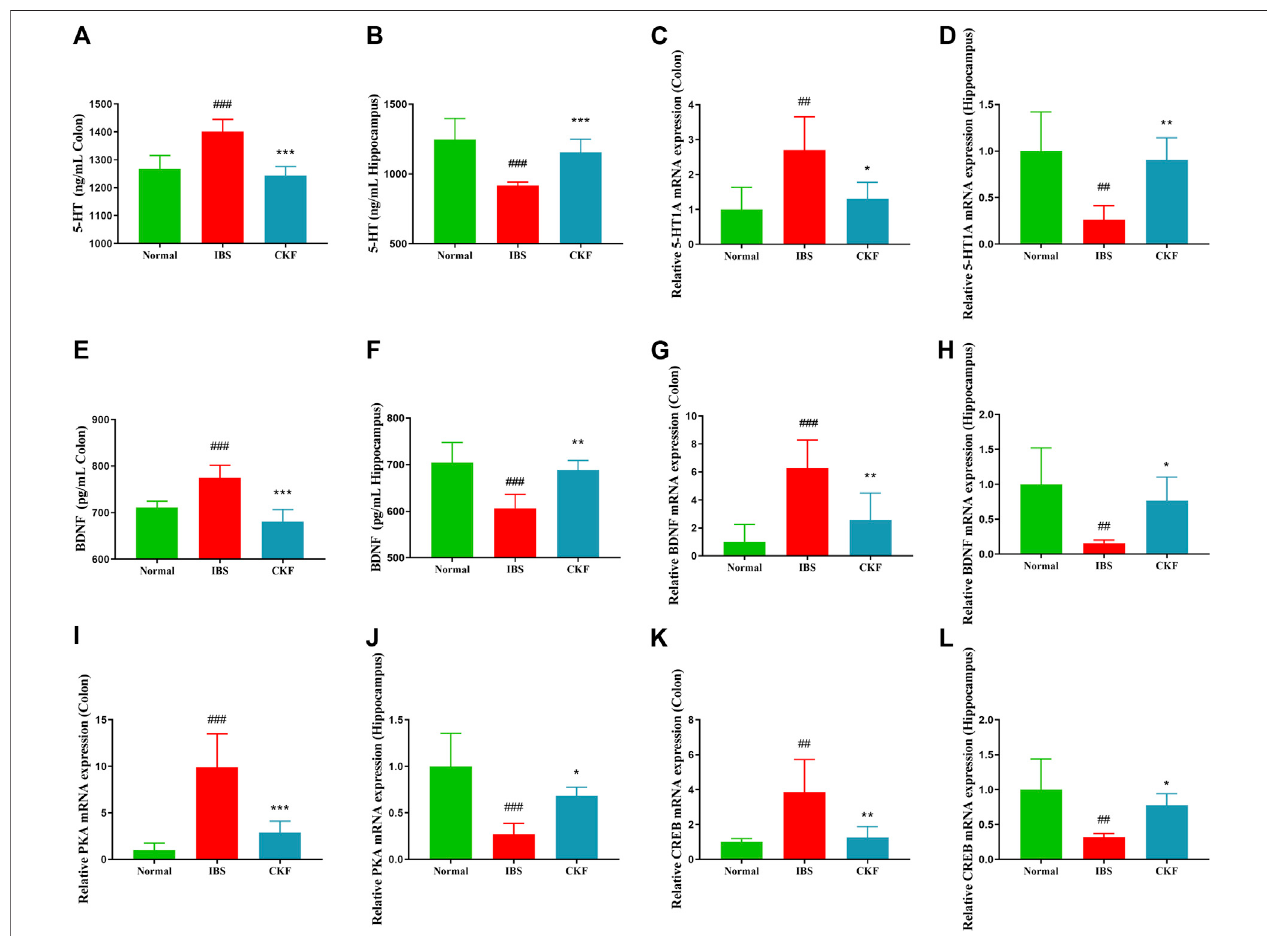
FIGURE4| Chang-Kang-Fangformulaaffectsthelevelsof5-HT,5-HT1AR,BDNF,PKA,andCREBinIBSrats. (A,B) 5-HTlevelsincolonandhippocampus. (C,D) Therelativeexpressionof5-HT1ARincolonandhippocampus. (E,F) TherelativeexpressionofBDNFincolonandhippocampus. (G,H) TherelativeexpressionofBDNF incolonandhippocampus. (I,J) TherelativeexpressionofPKAincolonandhippocampus. (K,L) TherelativeexpressionofCREBincolonandhippocampus.Valuesare presented as the means ± SD ( n = 6). ## p < 0.01, ### p < 0.001 compared to Normal, * p < 0.05, ** p < 0.01 and *** p < 0.001 compared to IBS.